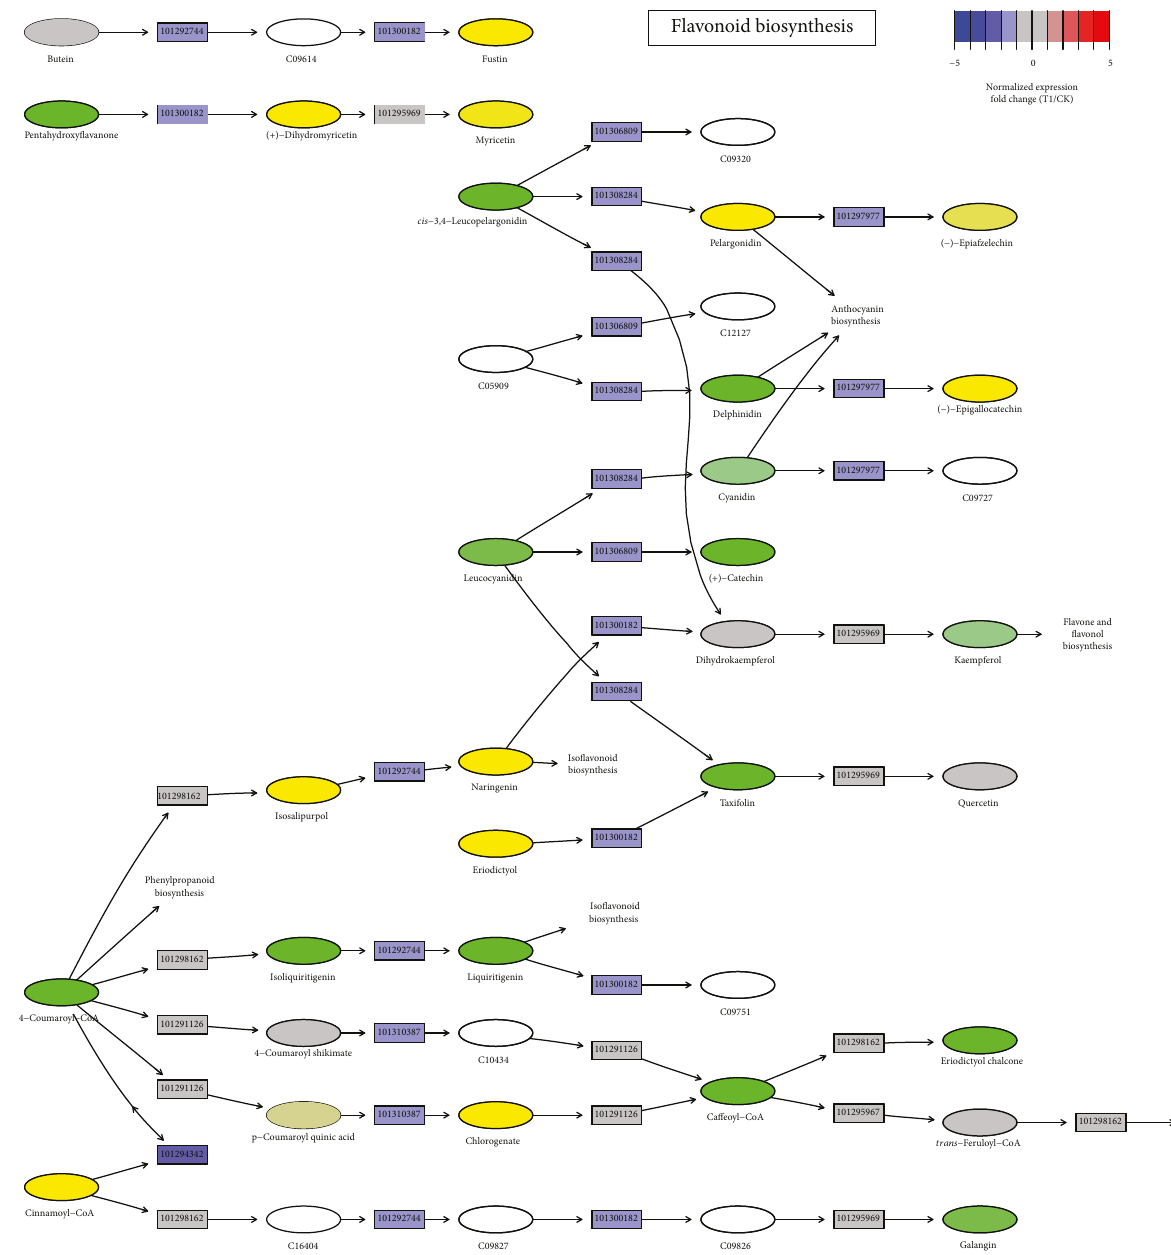
Figure 6: Flavonoid biosynthesis pathways mapped with relative expression levels (T1 vs . CK). Gene ID of F. vesca is indicated at the corresponding gene node if there